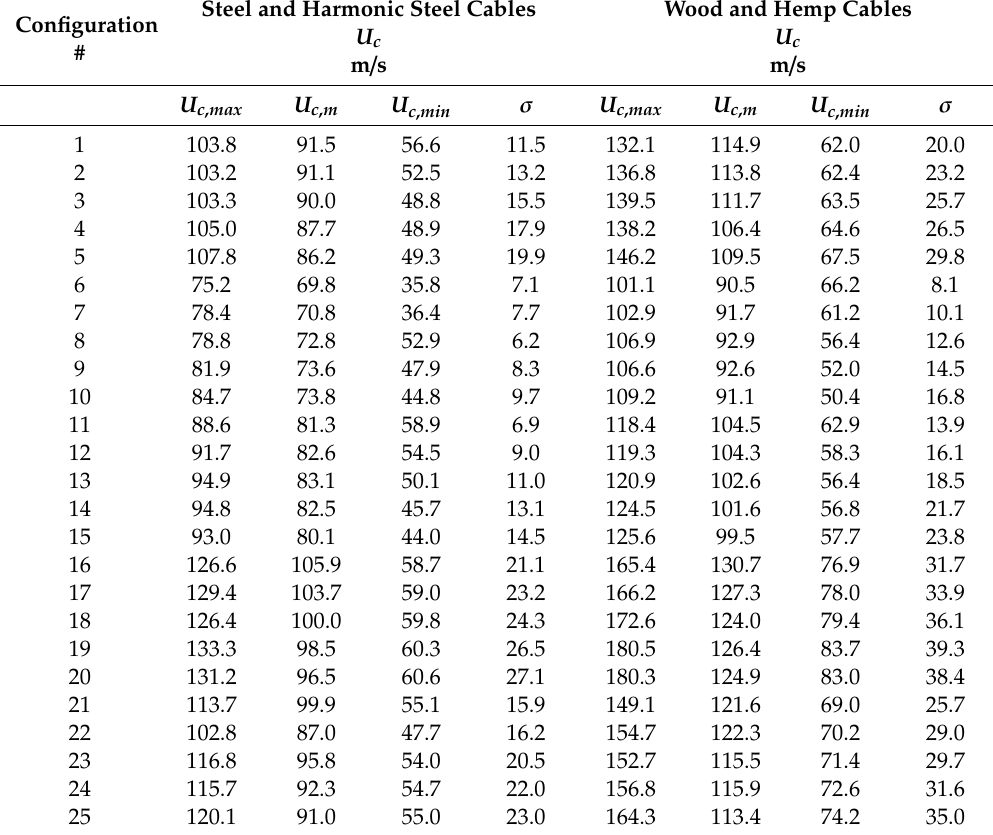
Table 5. Critical flutter speed U c estimated with ζ =